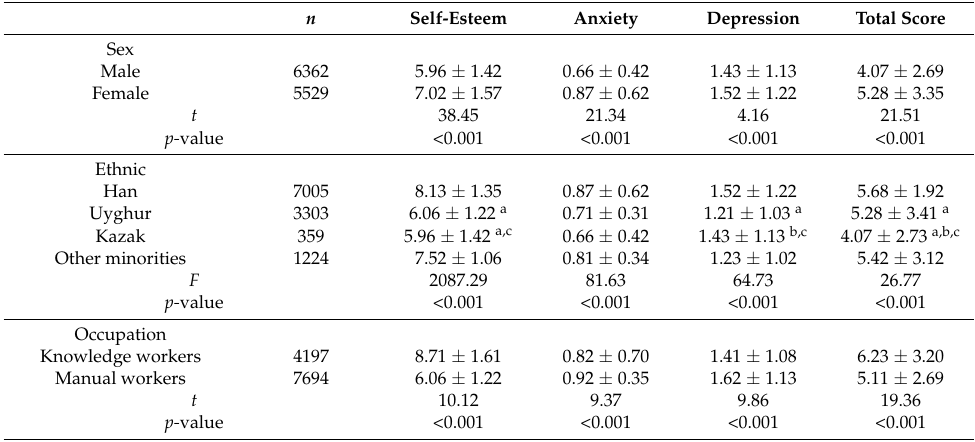
Table 3. The General Health Questionnaire (GHQ)-20 scale and subscales score comparison of occupational group with different demographic